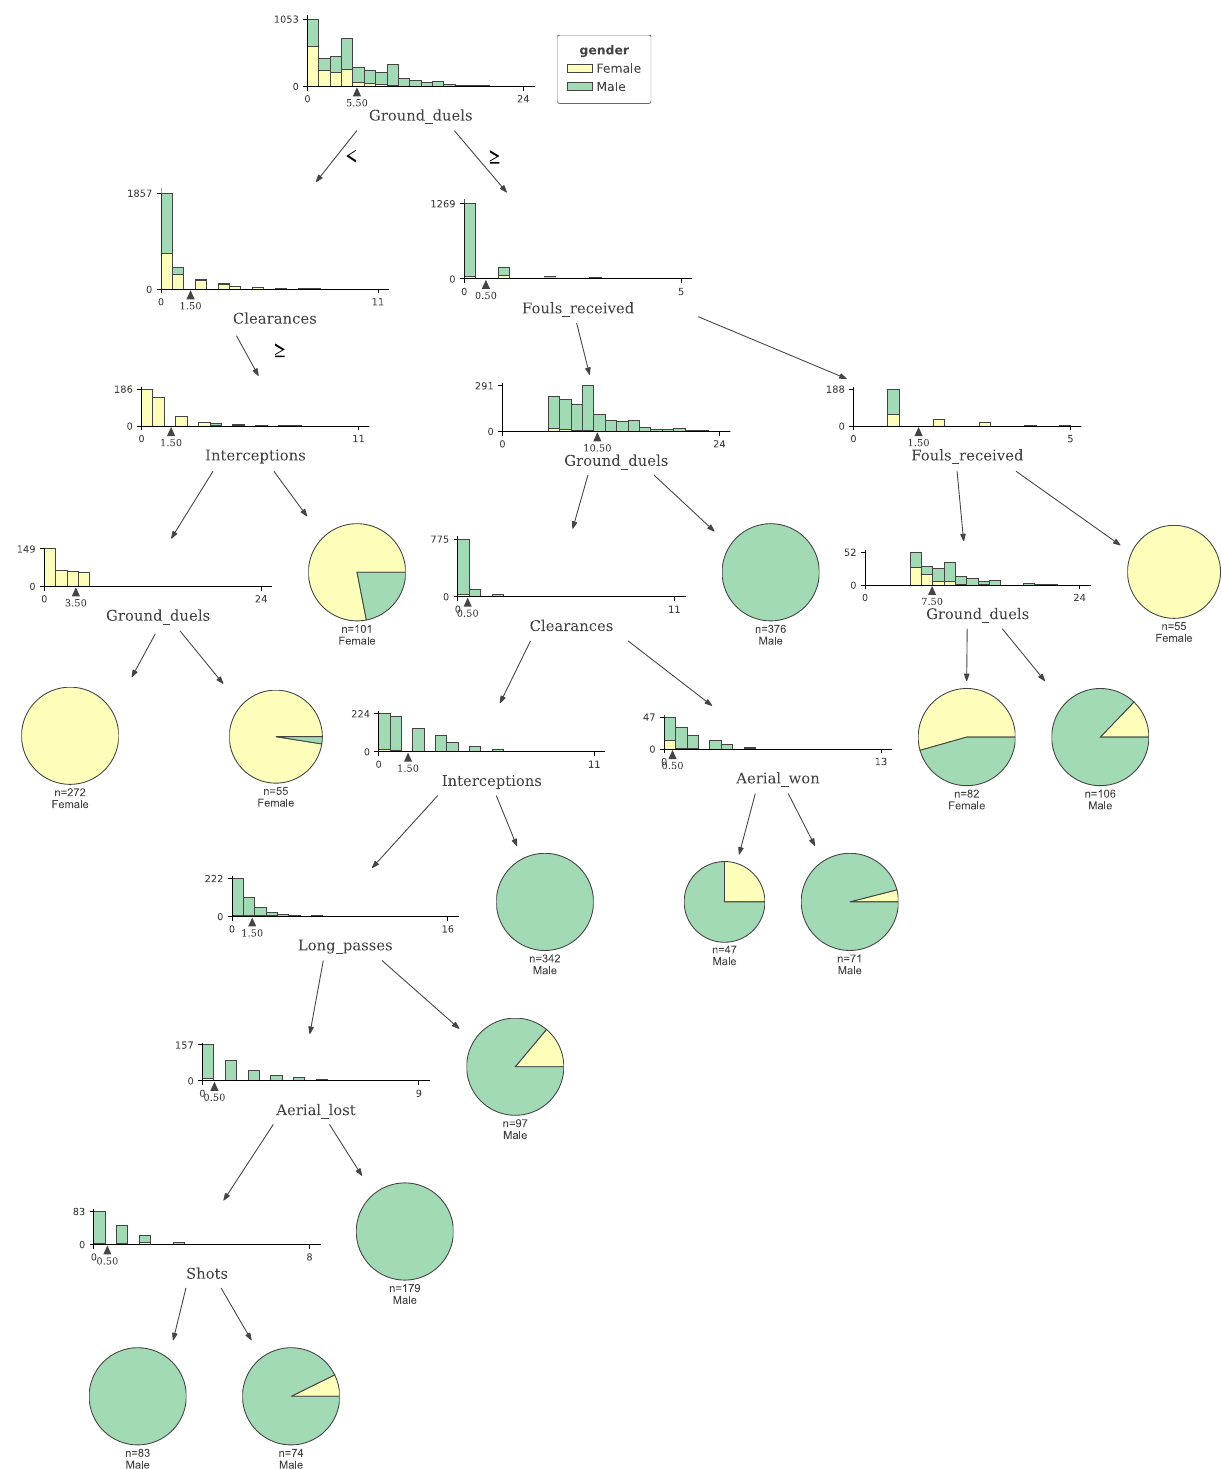
Figure 2. Visual representation of the pruned Decision Tree model. This figure shows the decision tree model’s root using ground duels as the highest entropy split. Early leaf nodes appear at the fourth level of the tree with high degree of